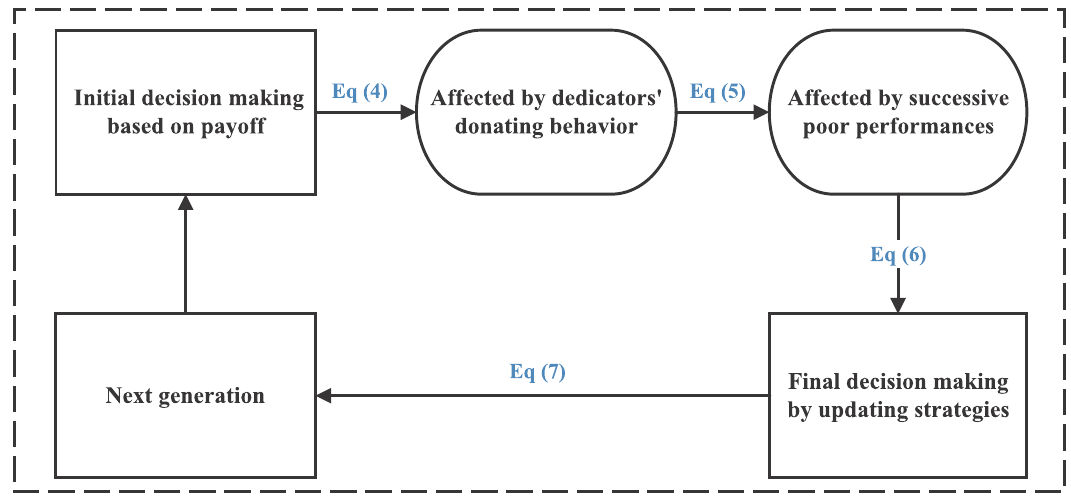
Fig 3. The circulatory process of decision-making of cooperators and defectors. Cooperators and defectors make decisions at the same time. Decisions of cooperators and defectors are driven by personal payoff and affected by dedicators’ donating behavior based on emotional effect and successive poor performances.